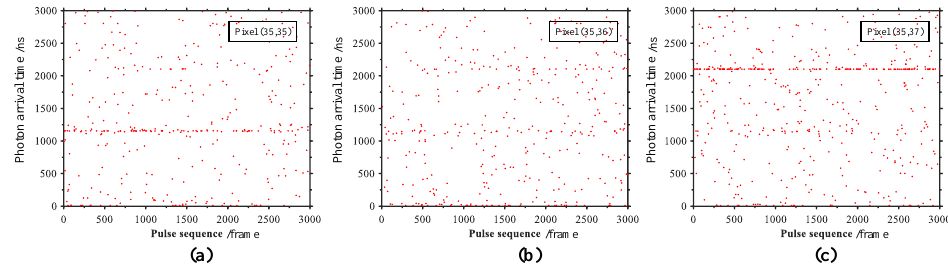
Figure 5. Original photon events at three adjacent pixels of the SPAD detector. The horizontal axis is the pulse sequence and the vertical axis is the time difference relative to the gate opening time. Note that pixels (35, 35) and (35, 37) in ( a , c ) correspond to two adjacent beams of the LiDAR transceiver. ( b ) Pixel (35, 36) has no fiber